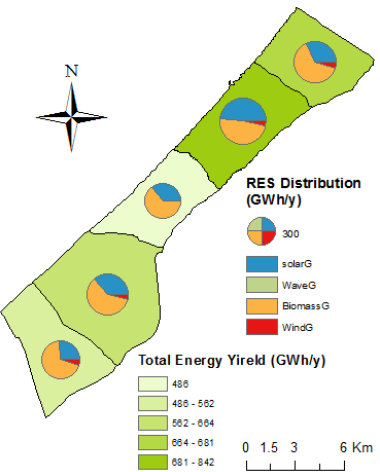
Figure 12. Spatial distribution of the total energy yield (GWh/year) from RESs in the GS and the proportion of biomass, solar, wave, and wind energy.